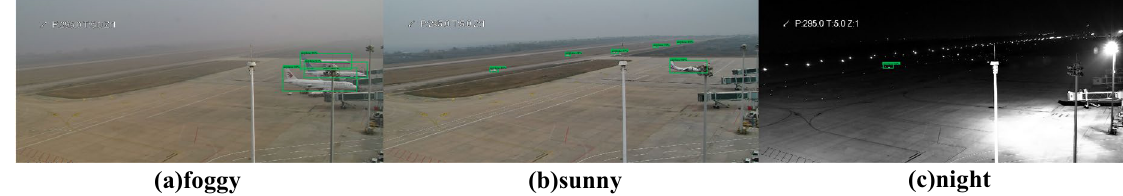
Figure 6. RPD detection renderings in different scenarios.